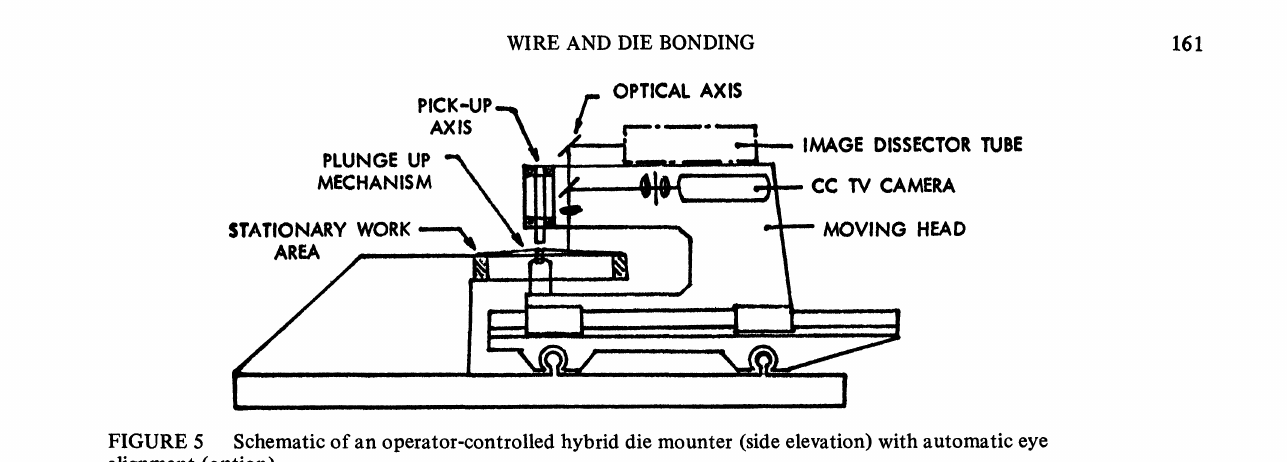
Schematic of an operator-controlled hybrid die mounter (side elevation) with automatic eye alignment